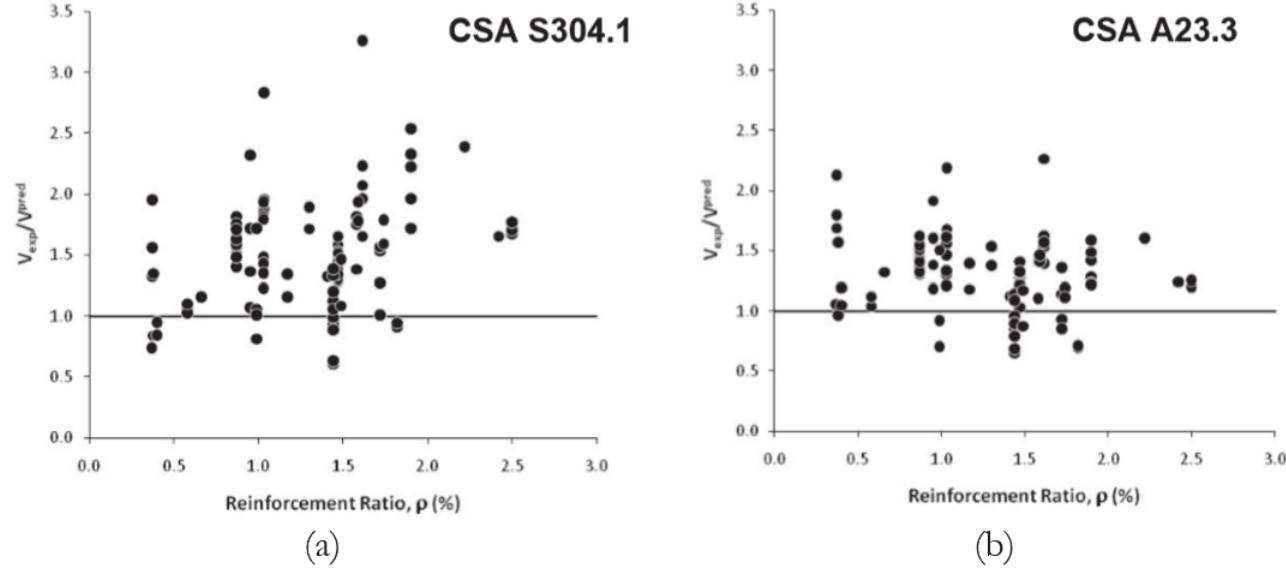
Comparison between the value of the experimental and theoretical shear force ratio (Y-axis) and the longitudinal reinforcement rate (X-axis) according to the Canadian Masonry Standard (a) and the Canadian Concrete Standard